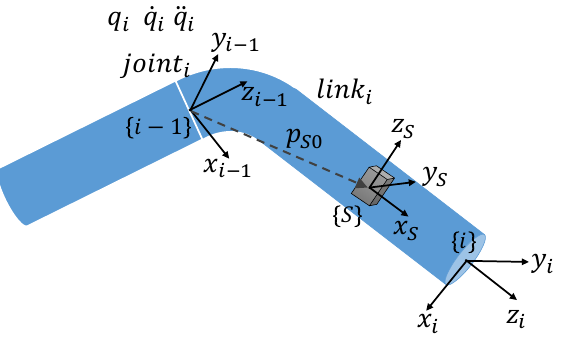
Figure 5. Accelerometer calibration